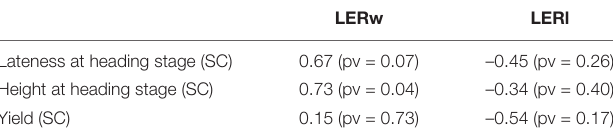
TABLE 9 | Estimates and p -values (pv) of Pearson correlation coefficients between lateness at heading stage, height at heading stage and yield in SC, and producer (LERw) and associate (LERl) effects of the 8 wheat genotypes. LERw